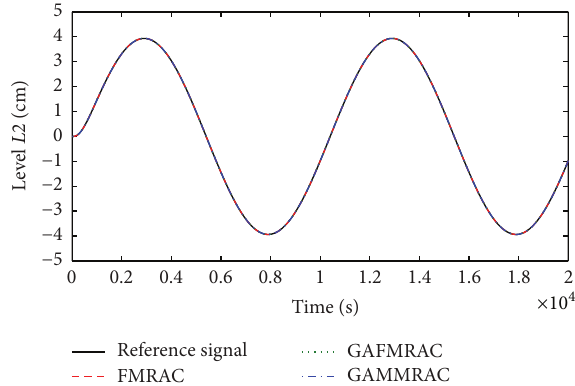
Figure9:Responseofthethreecontrollerstoasinusoidalcommand